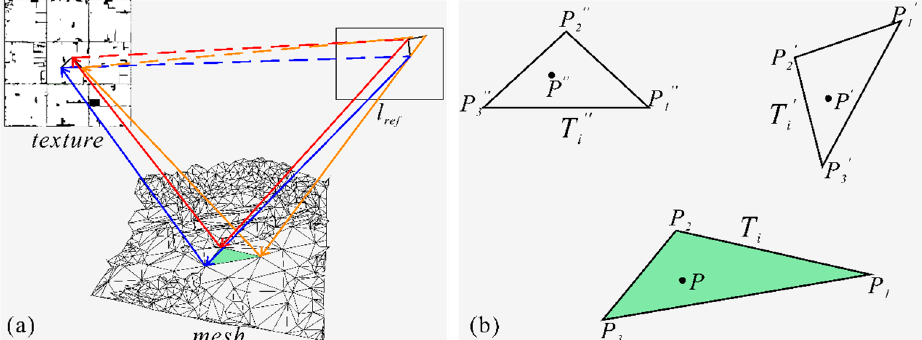
Figure 5. Schematic diagram of the transformation relationship among the 3D mesh, view, and texture. ( a ) Whole drawing (the bottom is the mesh, the top left is the texture, and the top right is the view reference image). ( b ) Enlarged drawing of three spatial relationships.